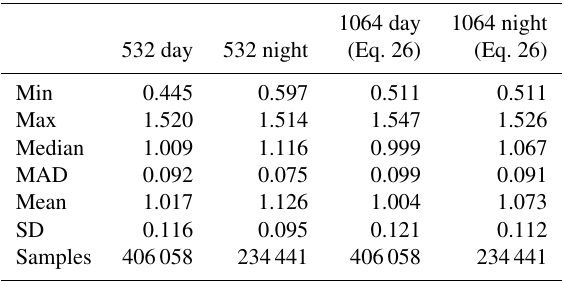
Figure 24. Occurrence frequencies of the 1064nm relative calibra- tion coefficients (Eq. 26) for opaque water clouds detected over global oceans during all of 2015. Daytime results are shown in or- ange and nighttime results in dark red. Table 3. Descriptive statistics for the relative calibration coefficients computed at both wavelengths for opaque water clouds detected over global oceans during all of 2015; values at 1064nm report wa- ter cloud calibration coefficients divided by cirrus cloud calibration coefficients, whereas values at 532nm report water cloud calibra- tion coefficients divided by the 532nm calibration coefficients com- puted using molecular normalization (Kar et al., 2018; Getzewich et al., 2018).